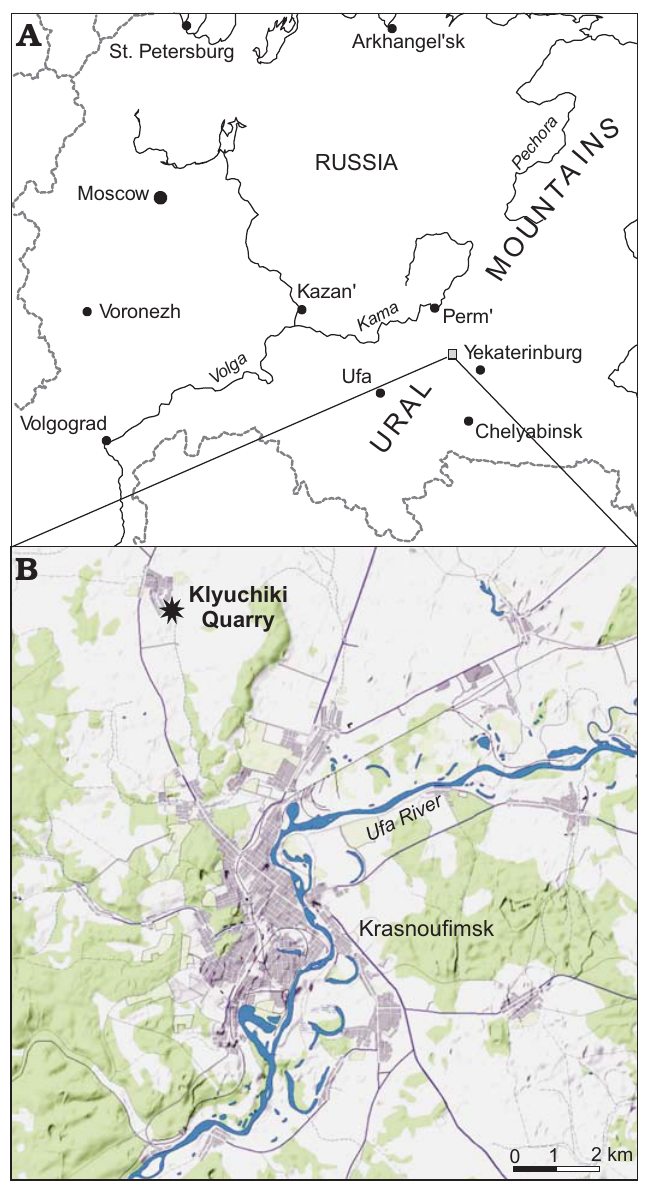
Fig. 1. Maps of Ural ( A ) and Krasnoufimsk area ( B ; source of the map from https://yandex.ru/maps/) showing the location of Krasnoufimskie Klyuchiki